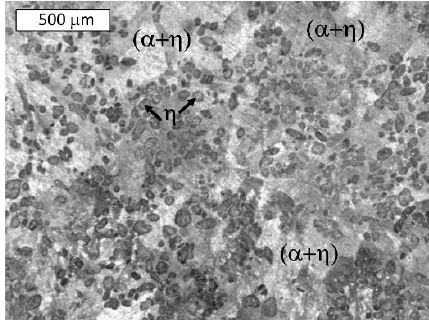
Figure 11. Stereoscopic image of a sample after polarization up to a potential of +300 mV vs. E corr . Selective dissolution of the dendritic η phase at the macroscopic scale. Materials 2020 , 13 , x FOR PEER REVIEW